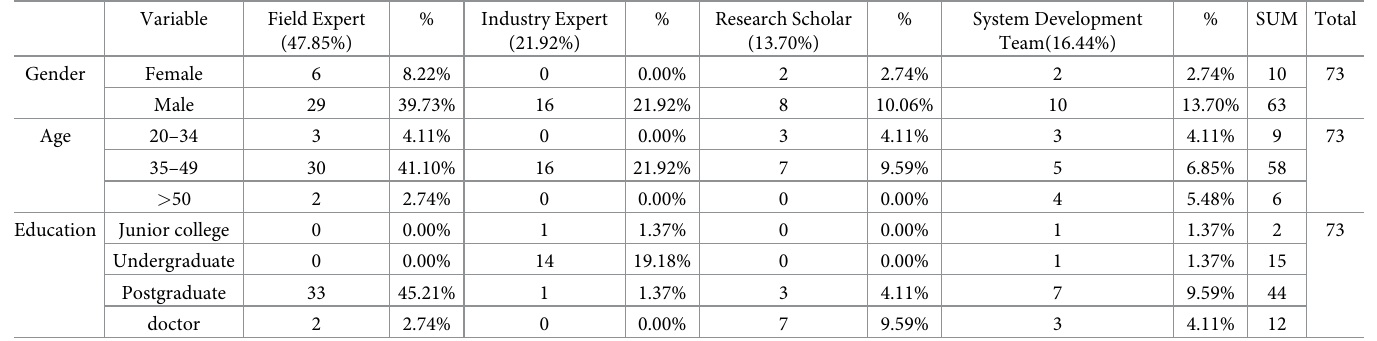
Table 2. A description of demographic data collected.